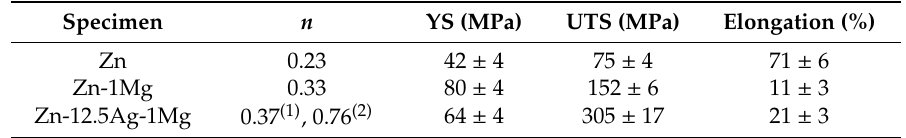
Table 4. Mechanical properties and strain hardening exponent, n , of the investigated alloys. Specimen n